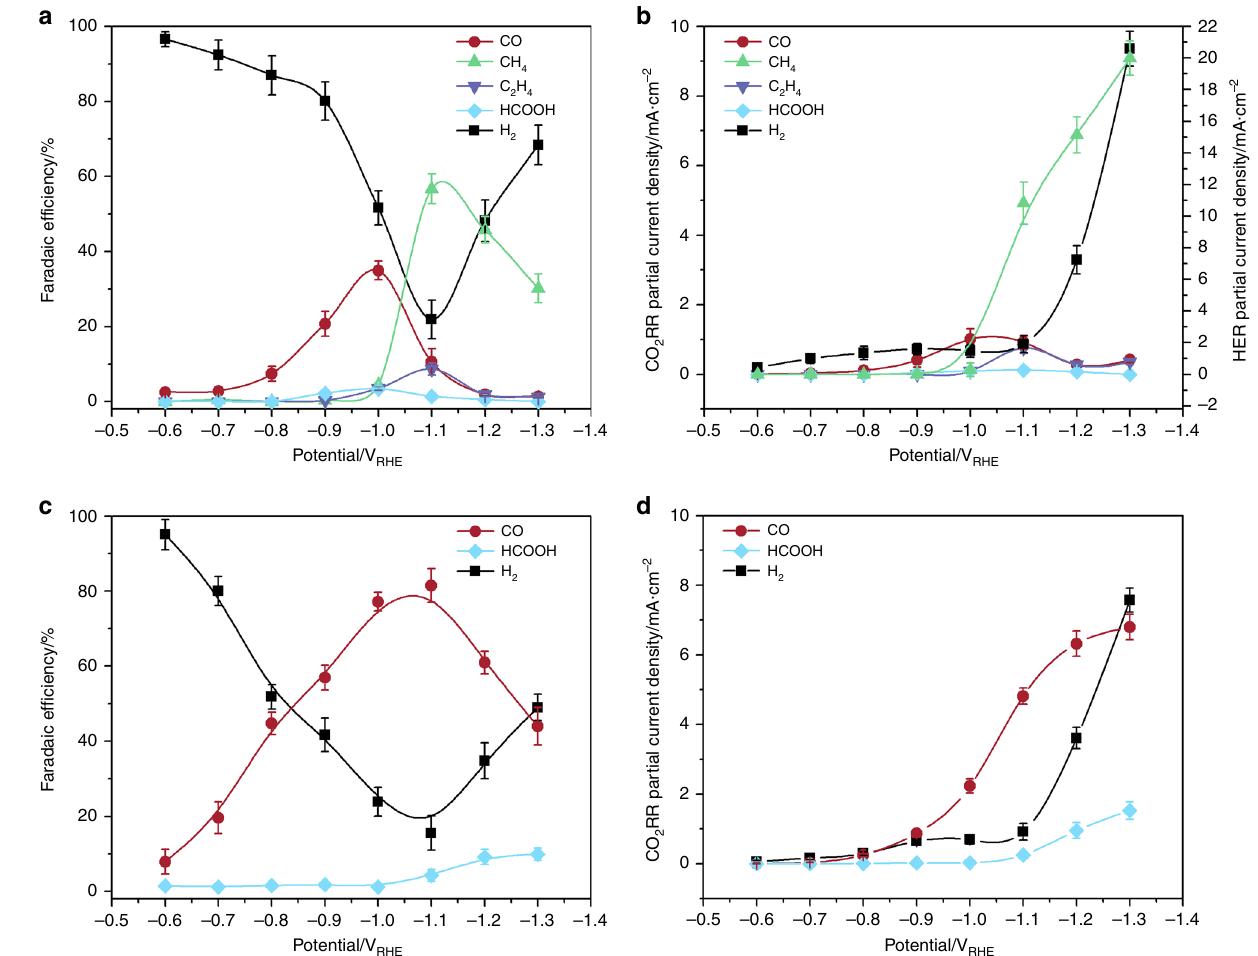
Fig. 4 Carbon dioxide electrolysis on the silver – copper and bare silver surfaces. Faradaic ef fi ciencies ( a ) and partial current densities ( b ) of CO 2 electrolysis products on the Ag-Cu surface achieved at a Cu 2 + concentration of 1.5 ppm. Faradaic ef fi ciencies ( c ) and partial current densities ( d ) of CO 2 electrolysis products on a bare polycrystalline Ag surface. The error bars represent the standard deviation from at least three independent